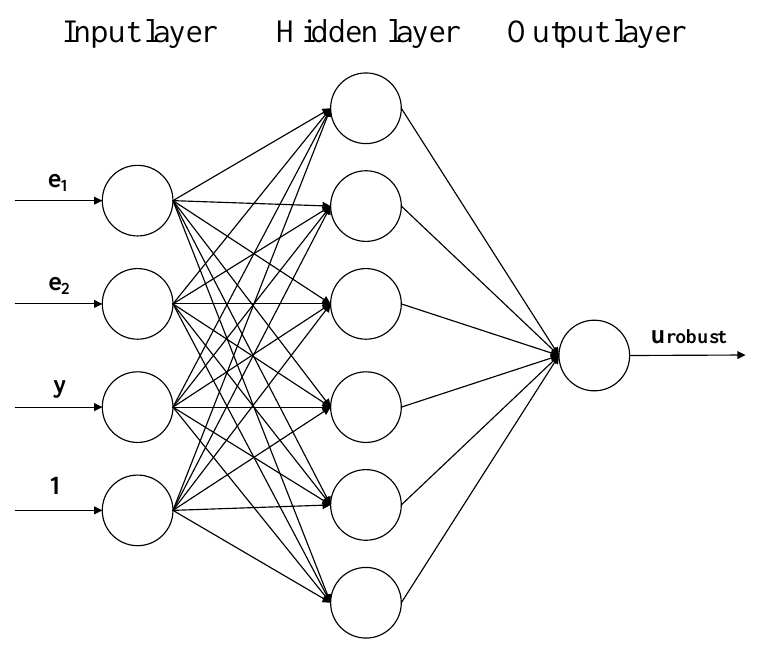
Figure 4. RBFNN internal structure for optimizing LESO input signal.